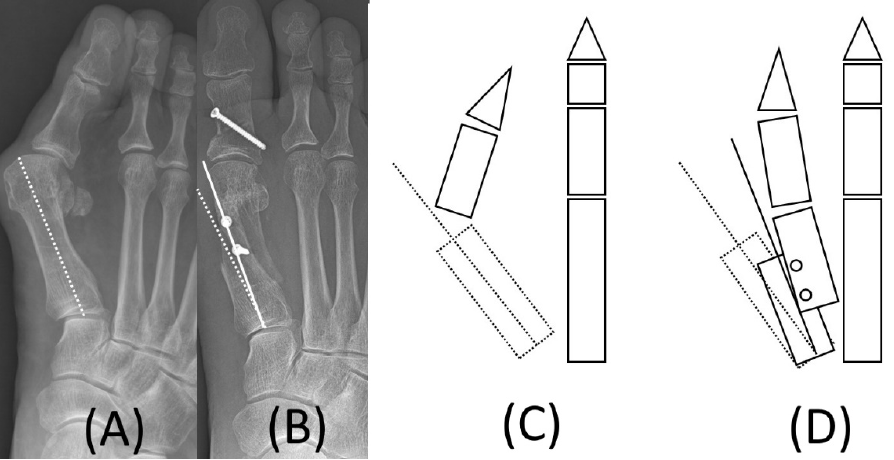
Figure 3. Anatomical axis of the first metatarsal in pre- and post-operative plain radiographs. Both mechanical and anatomical axis of the first metatarsal (dot line) are the same in pre-operative plain